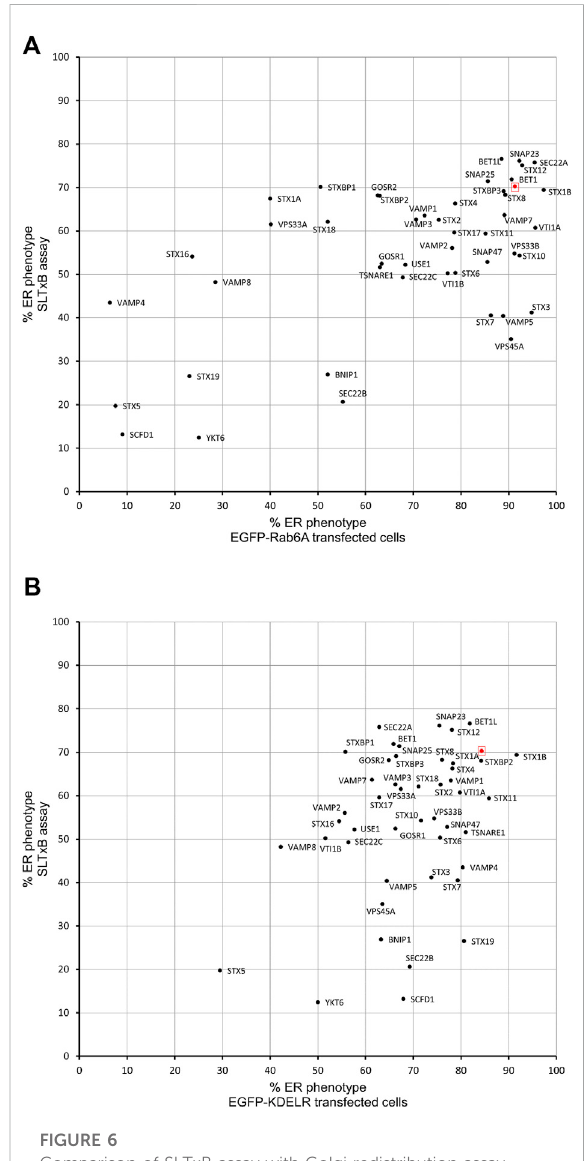
FIGURE 6 Comparison of SLTxB assay with Golgi redistribution assay. (A) Scatterplot showing the percentage of ER phenotypes in the populationafter depletion ofeach SNARE or SNARE-likeprotein in BFAtreatedEGFP-Rab6Aexpressingcellsandeachdepletion in SLTxB treated cells. The x-axis represents the percentage of ER phenotypes resulting from each depletion in EGFP-Rab6A transfected cells, and the y-axis represents the percentage of ER phenotypes resulting from each depletion in SLTxB treated cells. The highlighted red dot represents the result from negative (NEG) control transfected cells. Pearson ’ s coef fi cient is 0.46. (B) Scatterplot showing the percentage of ER phenotypes in the populationafter depletion ofeach SNARE or SNARE-likeprotein in BFA treated EGFP-KDELR expressing cells and each depletion in SLTxB treated cells. The x-axis represents the percentage of ER phenotypes resulting from each depletion in EGFP-KDELR transfected cells, and the y-axis represents the percentage of ER phenotypes resulting from each depletion in SLTxB treated cells. The highlighted red dot represents the result from the negative (NEG) control transfected cells. Pearson ’ s coef fi cient is